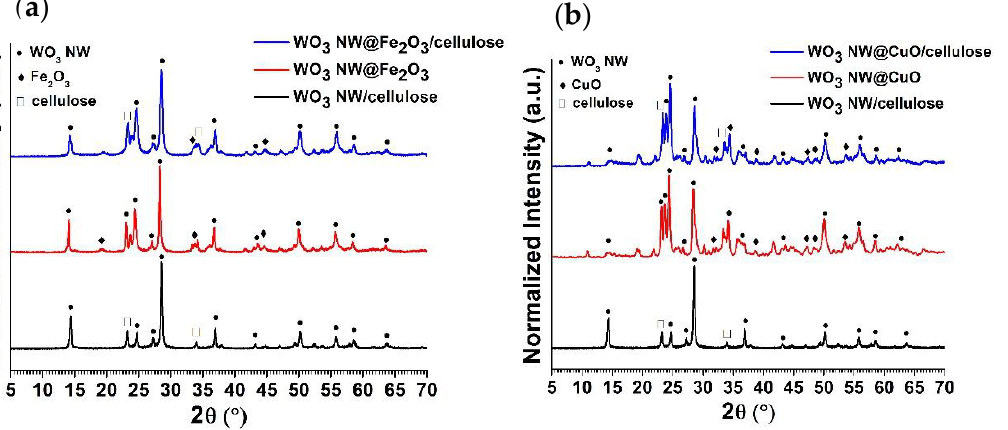
Figure 5. XRD of WO 3 NW@Fe 2 O 3 /cellulose ( a ), and WO 3 NW@CuO/cellulose ( b ) hybrid mem- branes.